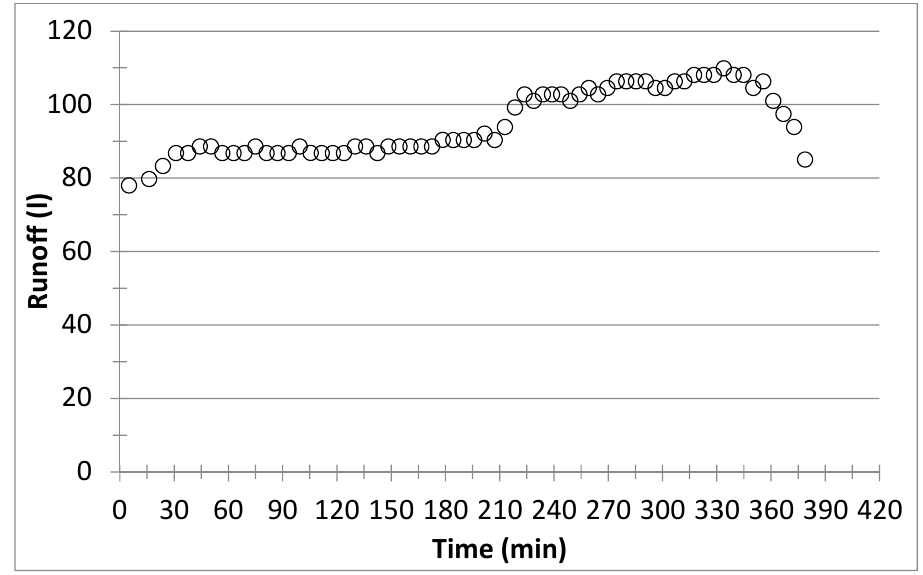
Figure 3. Surface runoff hydrograph of the low pollutant loadings (LPL) experiment. The time in the horizontal axis began when the irrigation system was turned on and ended six hours later when the system was turned off.